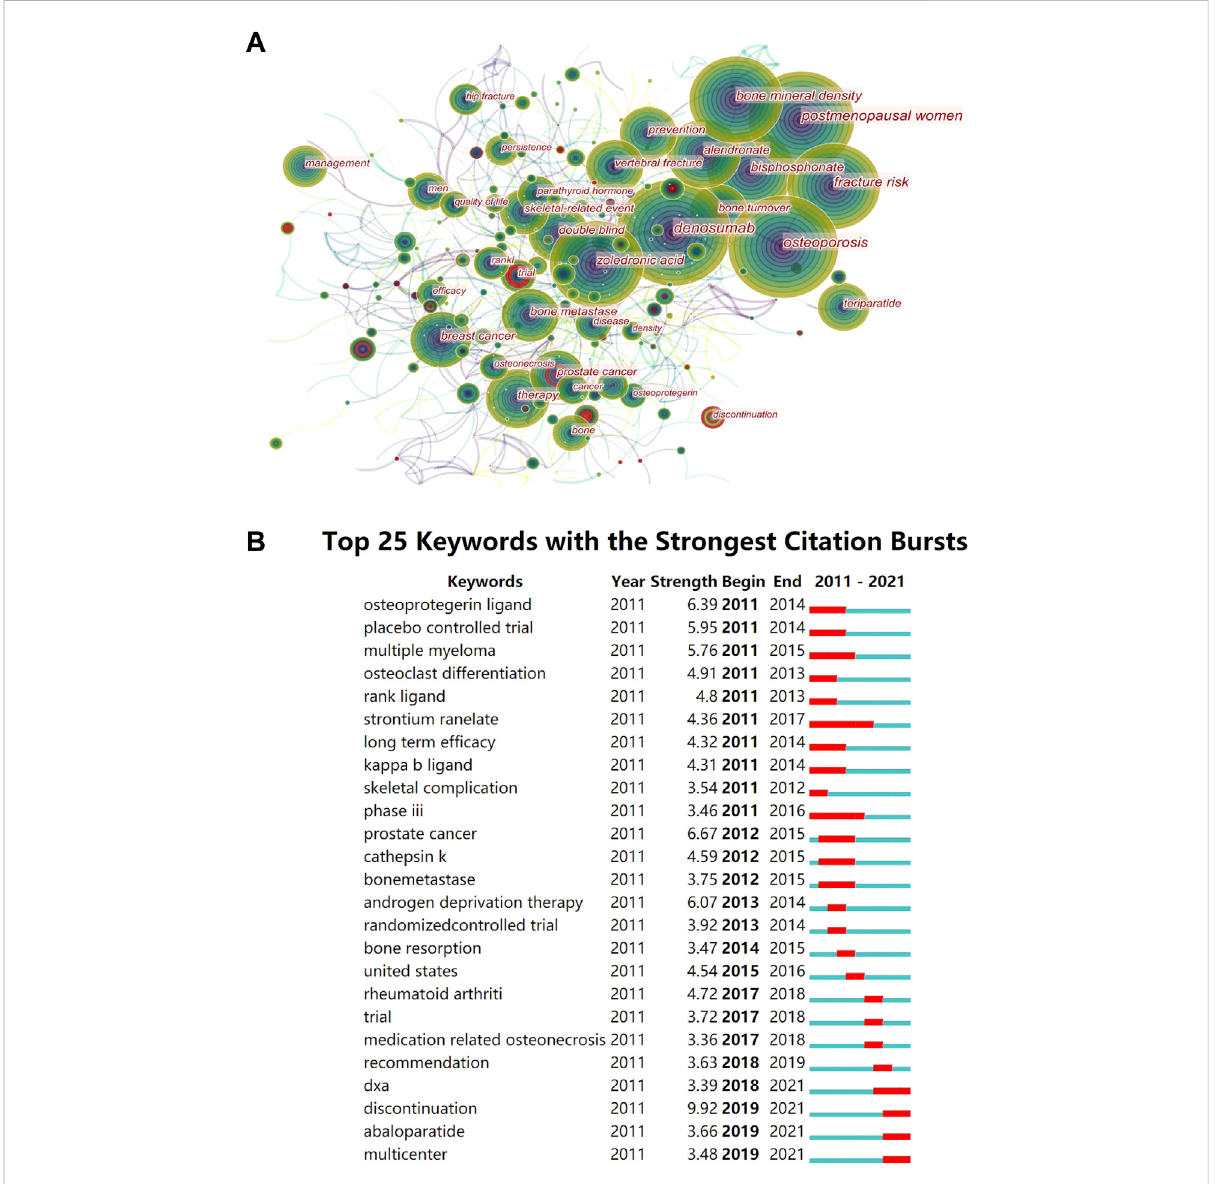
FIGURE 6 Visualdiagramofkeywords. (A) Keywordsco-occurrencegraphindenosumabfrom2011to2021.Thenodesrepresentkeywords,andthelines represent co-occurrence. The red circle indicates that the keyword has a citation burst. The area represents the frequency of keyword occurrence. The purple outer circle represents higher centrality. (B) Top 25 keywords with the strongest citation bursts. The red bars are the years of burst